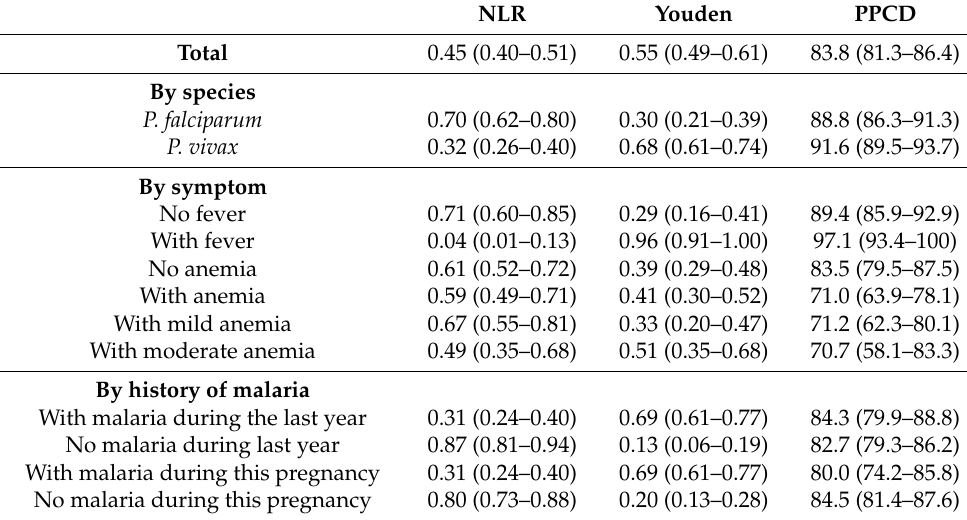
Table 3. Likelihood ratios, validity indices, and Youden index values of the TBS compared to qPCR for the diagnosis of gestational malaria in the total population and in subgroups according to species, symptomatology, and history of malaria.